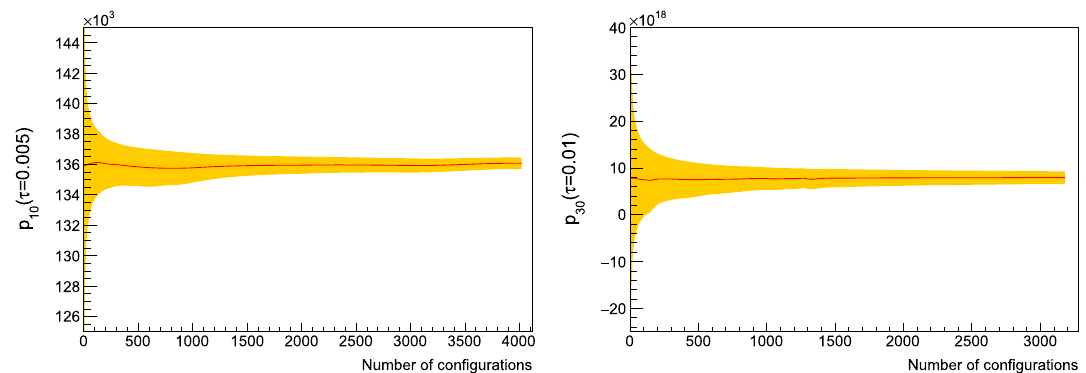
Fig. 7 Average of two plaquette coefficients at L = 48 as a function of the number of configurations. The error band corresponds to the standard deviation of the